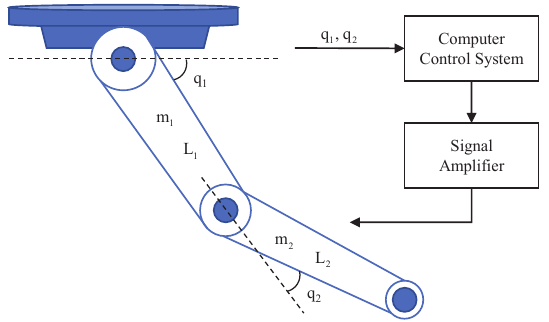
Figure 2. Two–link underwater robot manipulator control system.